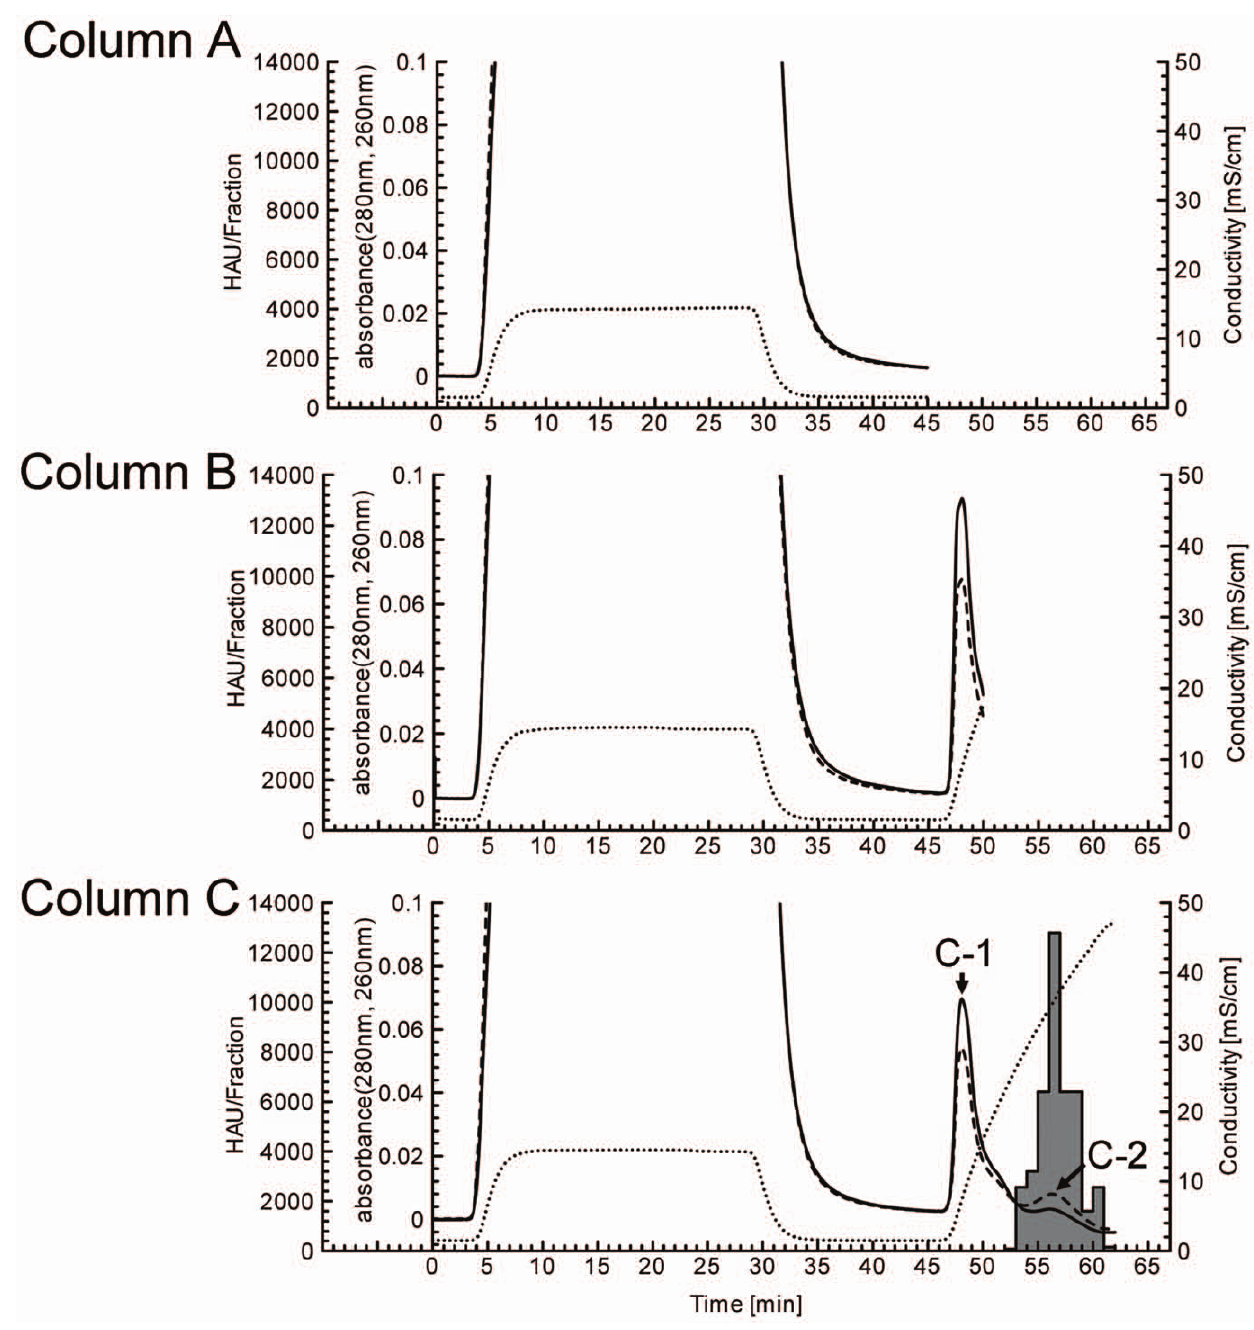
Figure 2. HAp chromatogram of dengue virus culture fluids from 3 different elution processes. The solid line is the UV absorbance at 280 nm, the broken line is the UV absorbance at 260 nm, and the dashed line is the conductivity of the elution. The shaded histogram indicates the hemagglutination unit of each fraction. Column A: No elution; Column B: 10–207 mM NaPB (pH 7.2) gradient elution; Column C: 10–600 mM NaPB (pH 7.2) gradient elution. C-1: Admixture proteins peak; C-2: Virus